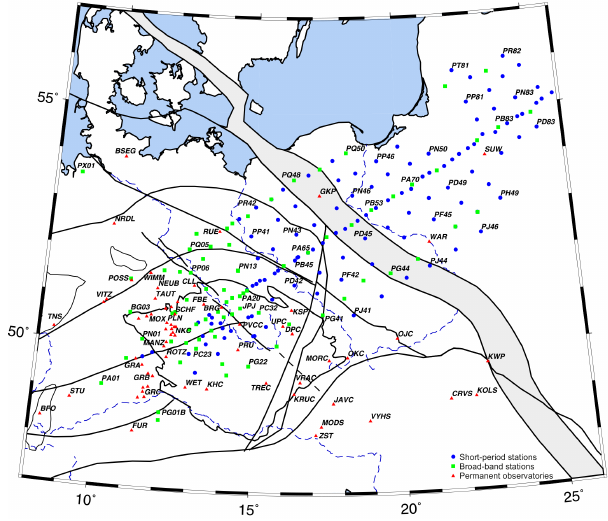
Figure 1. Simplified tectonic sketch of the Trans-European Su- ture Zone (TESZ) and adjacent areas according to Pharaoh (1999). STZ stands for the Sorgenfrei–Tornquist Zone, TBU for the Teplá– Barrandian Unit included in the Moldanubian Zone of the Bo- hemian Massif (BM).